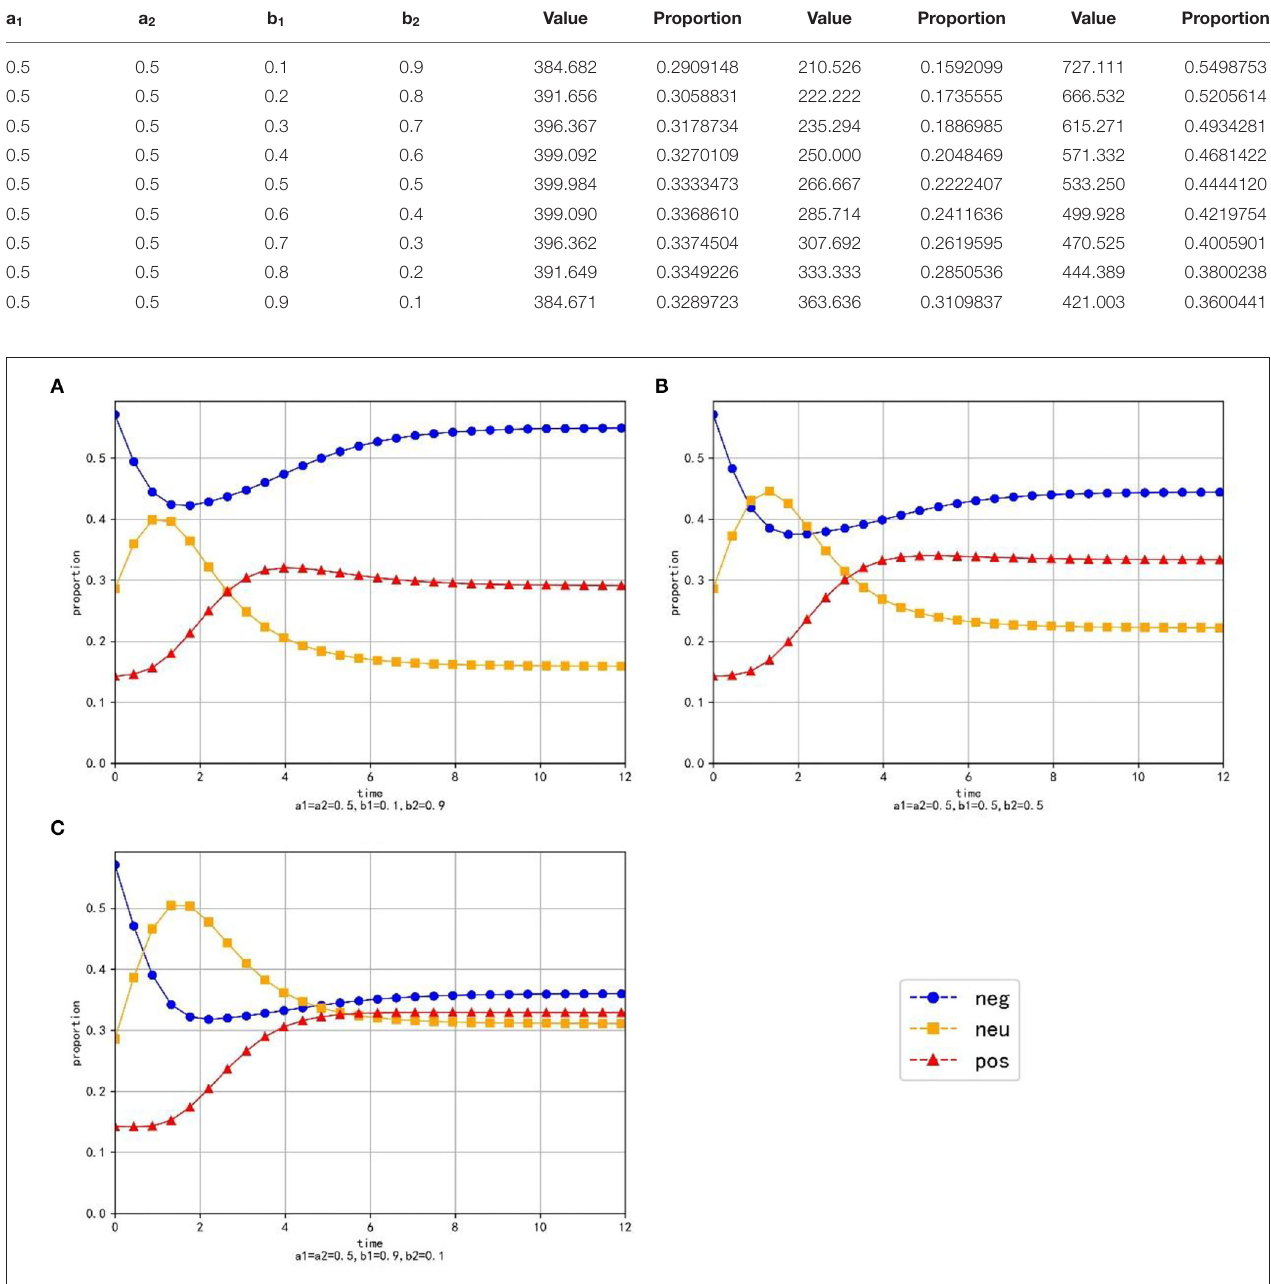
FIGURE 5 | The evolution trend of the proportion of three emotions under the condition of changing the conversion proportion. (A) When a 1 = a 2 = 0.5, b 1 = 0.2 and b 2 = 0.9. (B) When a 1 = a 2 = 0.5, b 1 = 0.5 and b 2 = 0.5. (C) When a 1 = a 2 = 0.5, b 1 = 0.9 and b 2 = 0.1.